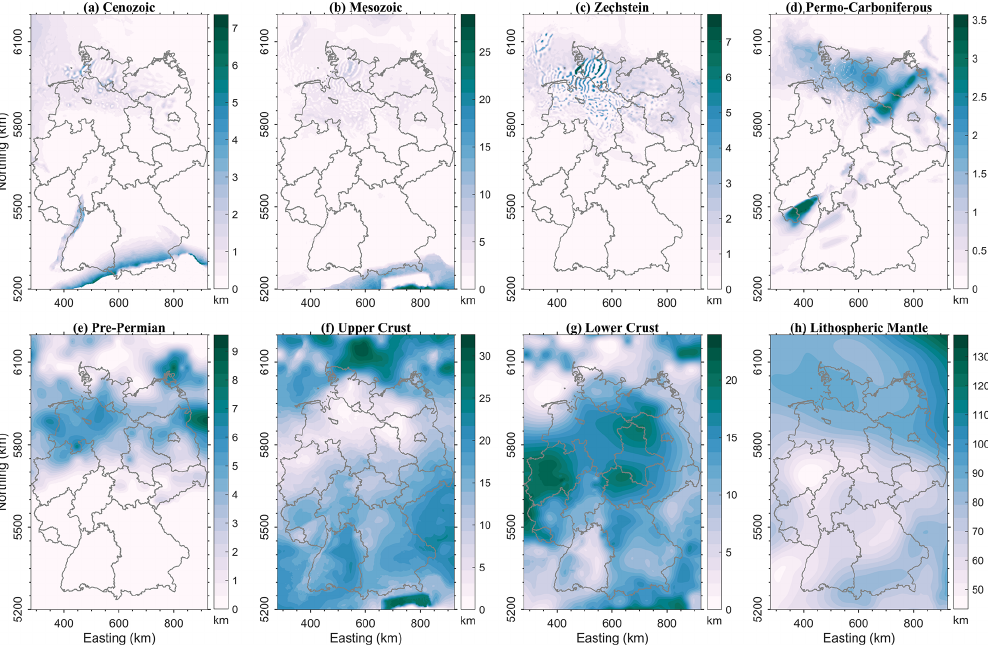
Figure 2. Thicknesses of the major structural layers of the 3-D-D model: (a) Cenozoic; (b) Mesozoic; (c) Zechstein; (d) Permo- Carboniferous; (e) Pre-Permian; (f) Upper Crust; (g) Lower Crust; (h) Lithospheric Mantle. Colour bars show thickness in